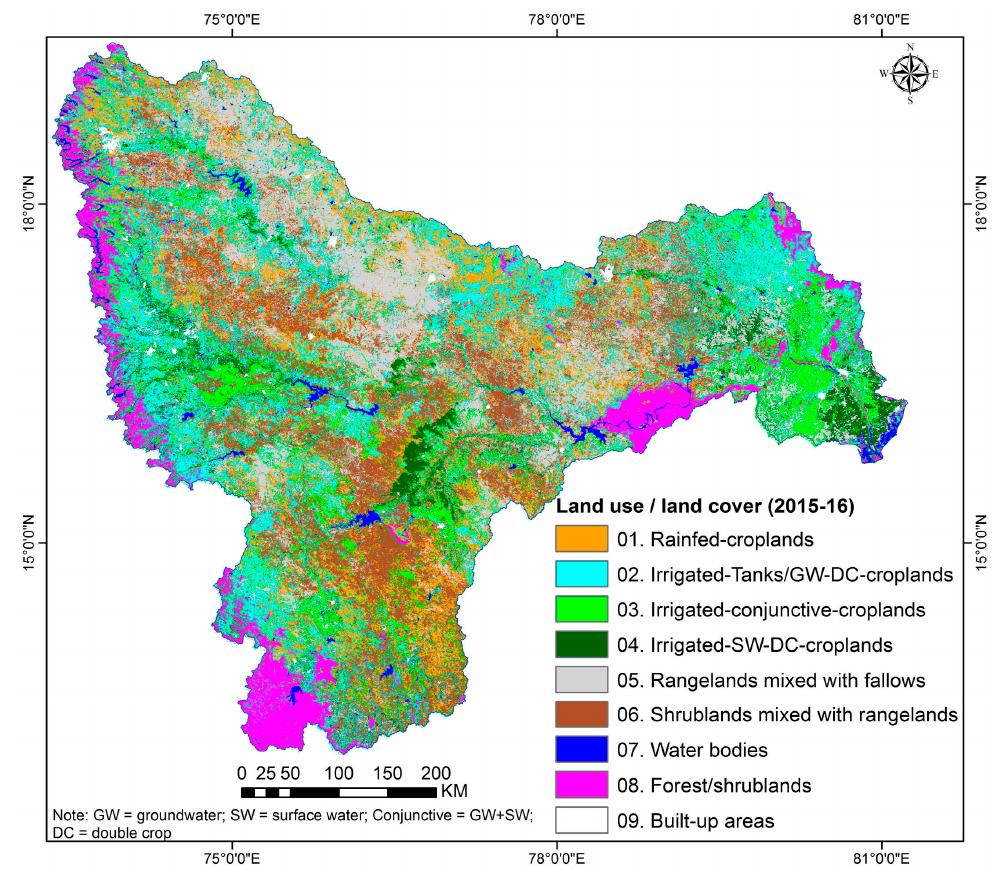
Figure 5. Spatial distribution of LULC (derived from 2015–2016 MODIS composite).